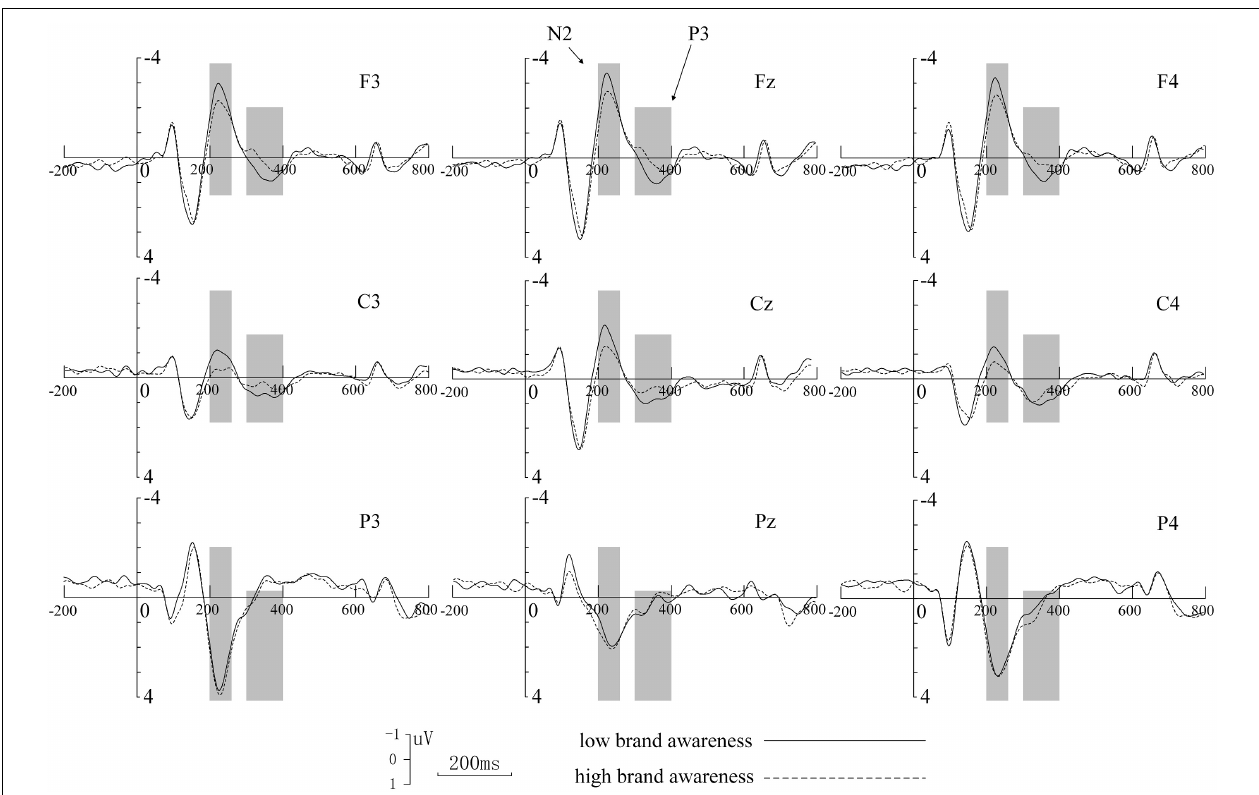
FIGURE 2 | Raw ERPs waveforms at 9 electrode sites. Grand averaged ERPS elicited by stimuli with low brand awareness (solid line) vs. high brand awareness (dotted line) at 9 electrodes in the frontal, central, and parietal areas.